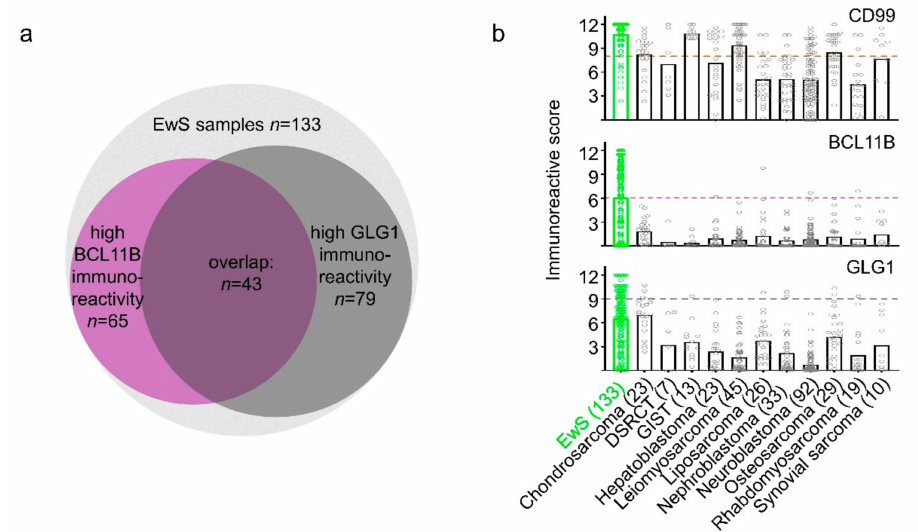
Figure 2. High immunoreactivity for BCL11B and GLG1 is diagnostic for EwS in CD99 positive samples. ( a ) Venn diagram representing all EwS samples in the TMA cohort of this study, the BCL11B and GLG1 high-expressing samples (at least 60% tumor cells stained, at least intermediate intensity) and their overlap. ( b ) Dot-plots indicating IRS values for CD99, BCL11B, and GLG1 in EwS and 11 di ff erential diagnoses. The number of samples per entity is given in brackets. Bars indicate mean IRS; dashed lines indicate optimal cut-o ff